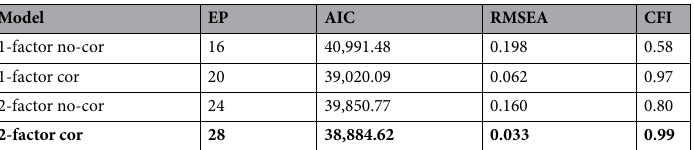
Table 3. Comparisons for phenotypic CFA. “cor” and “no-cor” signify whether a model is fitted with- or without correlations between residuals for items belonging to the same facet, respectively; EP number of estimated parameters, AIC Akaike’s Information Criterion, RMSEA Root Mean Squared Error of Approximation, CFI Confirmatory Fit Index. Best fitting model indicated in bold.